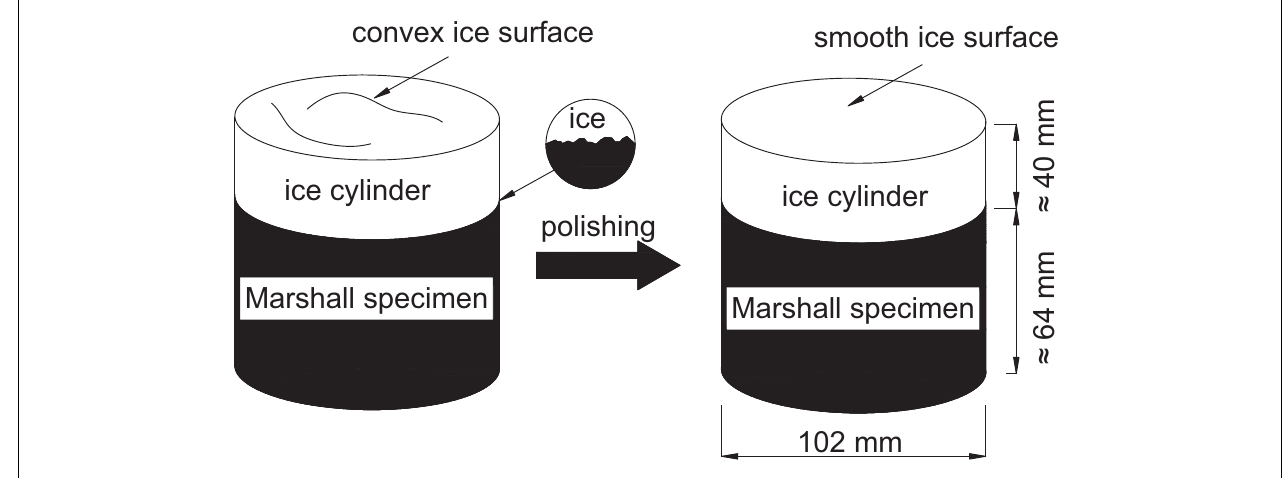
FIGURE 1 | Schematic diagram of specimen with ice and ice surface after polishing.